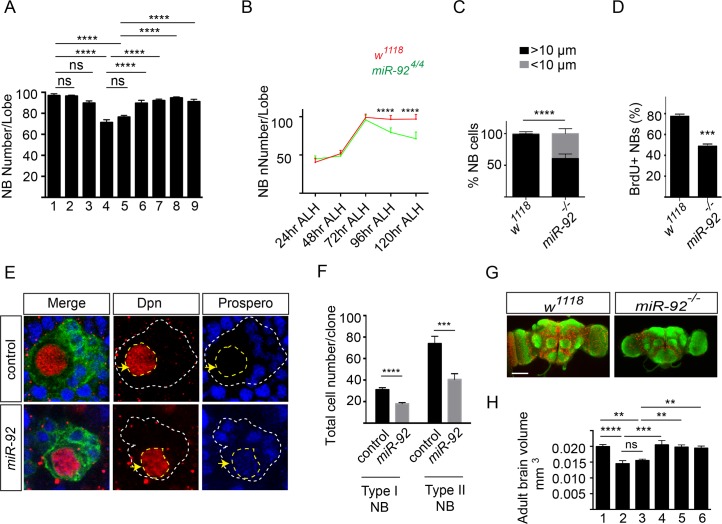
miR-92a and miR-92b regulate neuroblast self-renewal by inhibiting premature differentiation.(A) Number of brain neuroblasts at 120 hr ALH. 1: w
1118 (n = 17); 2: miR-92a
-/- (n = 13); 3: miR-92b
-/- (n = 12); 4: miR-92
4/4 (n = 15); 5: miR-92
1/4 (n = 20); 6: Insc-GAL4/UAS-miR-92a; miR-92
4/4 (n = 8); 7: Insc-GAL4/UAS-miR-92b; miR-92
4/4 (n = 8); 8: Insc-GAL4/UAS-miR-92a; miR-92
1/4 (n = 16); 9: Insc-GAL4/UAS-miR-92b; miR-92
1/4 (n = 15). Statistical significance was determined by one-way ANOVA. (B) Number of neuroblasts in wildtype (red) and miR-92
4/4 (green) mutants from 24 to 120 hr ALH. Statistical significance was determined by Student’s t test. Error bars show S.D. (C) Percentage of neuroblasts with diameter > 10 μm (black bar) and < 10 μm (grey bar) in wild type (n = 60) and miR-92
–/– (n = 60) mutant brains at 96 hr ALH. Fisher’s exact test was used for statistical analysis. (D) Percentage of BrdU+ wild type control (n = 15) and miR-92
–/– mutant (n = 16) larval neuroblasts. Statistical significance was determined by Student’s t test. (E) Neuroblast clones of wild type control and miR-92
4 mutants. Clones are marked with CD8::GFP (green). Yellow arrows mark Dpn+ neuroblasts. White dashed lines indicate the position of clones and yellow dashed line encircles the nucleus of neuroblast cell. Single focal planes are shown. (F) Comparison of wild type control (type I; n = 57, type II; n = 27) and miR-92
-/- mutant (type I; n = 67, type II; n = 33) clone sizes. (G) Whole-mount image of wild type and miR-92
–/– mutant male adult brains immunostained with the anti-HRP (green) to label axonal membranes and anti-Repo (red) to label glial cell nuclei. Scale bar: 100 μm. (H) Adult brain volume measured using ImageJ. 1: w
1118 (n = 10); 2: miR-92
4/4 (n = 10); 3: miR-92
1/4 (n = 8); 4: Insc-GAL4/UAS-miR-92a; miR-92
4/4 (n = 7); 5: Insc-GAL4/UAS-miR-92a; miR-92
1/4 (n = 9); 6: Insc-GAL4/UAS-miR-92b; miR-92
1/4 (n = 10). Statistical significance was determined by one-way ANOVA. Values are mean ± s.e.m. in all graphs unless otherwise stated. *: p < 0.05, **: p < 0.005, ***: p < 0.001, ****: p < 0.0001.